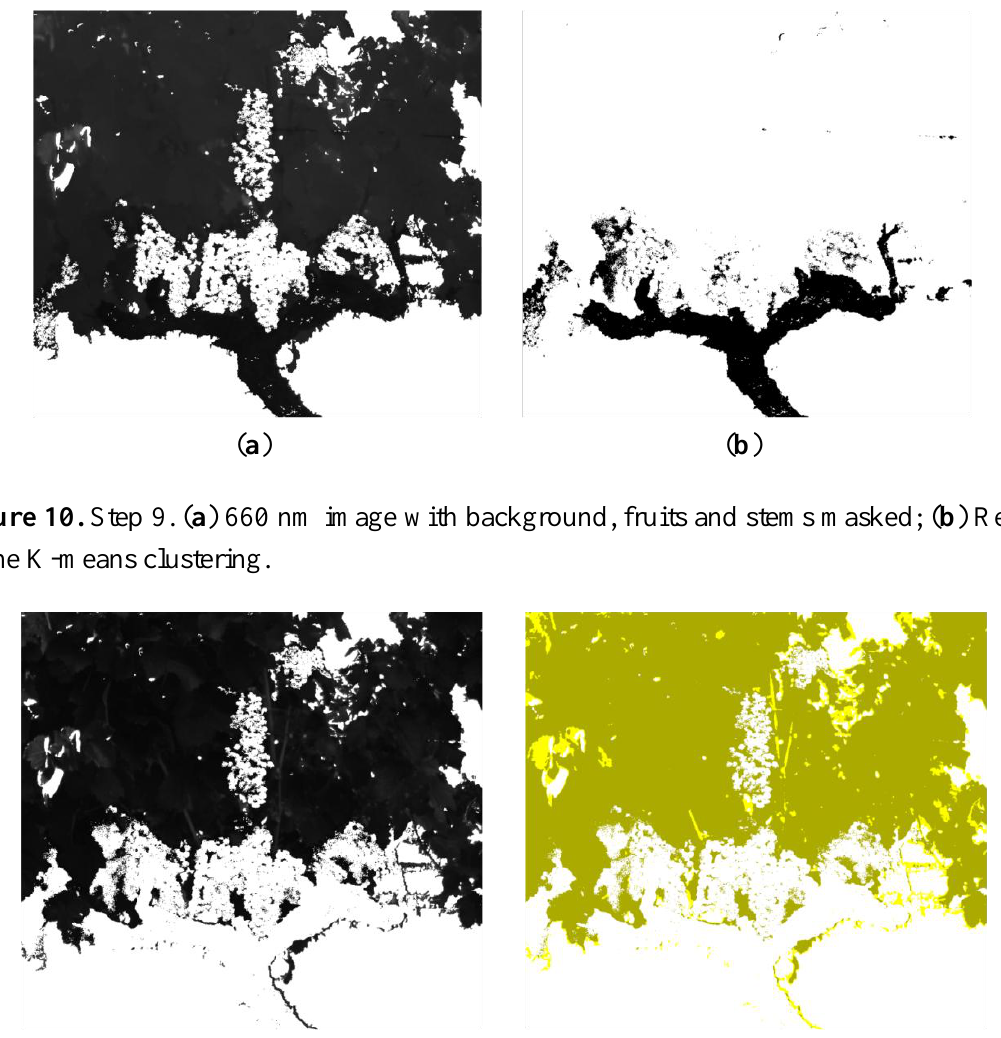
Figure 9. Step 8. ( a ) 880 nm image with background and fruits masked; ( b ) Stems mask (mask 3).